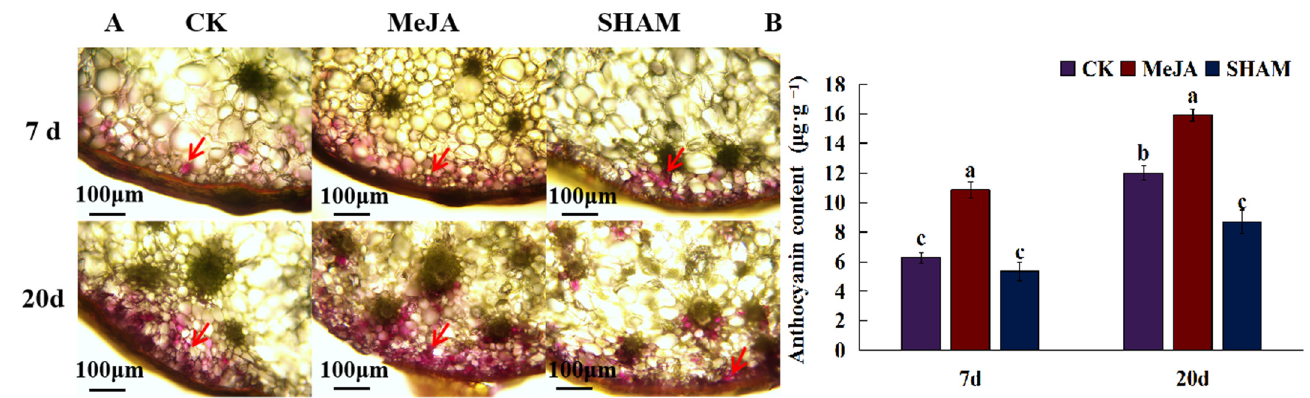
Figure 6. The effect of JA on the accumulation of anthocyanins in D. officinale pseudobulbs. ( A ) The localization of anthocyanins in D. officinale pseudobulbs. Red arrows indicate the accumulation of anthocyanins. ( B ) The content of anthocyanins in D. officinale pseudobulbs post-JA and its inhibitor (SHAM) treatment. The different letters represent significant difference at p < 0.05.